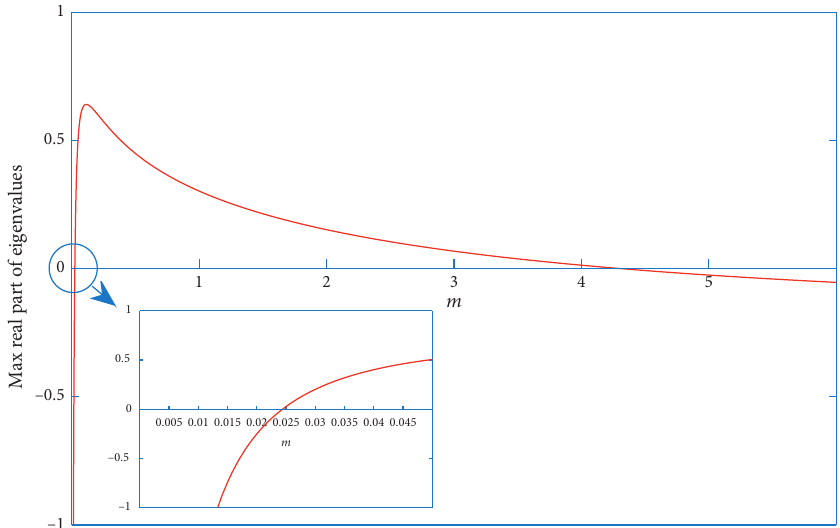
Figure 3: The relationship curve between the maximum real part of the eigenvalue of the characteristic equation (47) and parameter m with a � 40, c � 6, λ � 6, r � 0 . 5 ,b � 4 . 4 , d